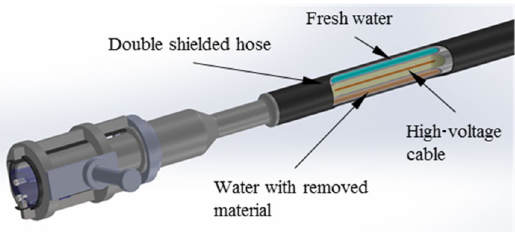
Fig. 17 Cross-section of the work equipment